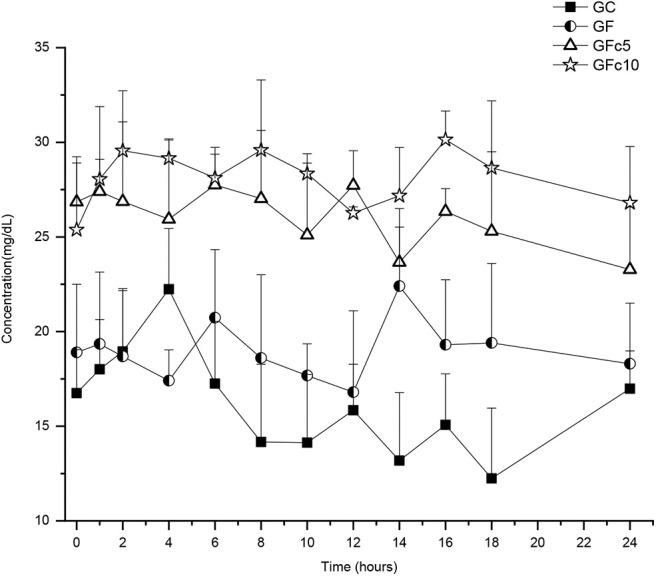
One day calcium serum profiles achieved with four calcium sources administered orally in 85-week-old Bovans-White hens: control group (GC), receiving a diet containing basal levels of 4.1% of calcium-carbonate; group GF treated as GC, but including the same dose of calcium-carbonate in FOLA pellets; group GFc5 treated as GF, but adding 6 ppm of capsicum-oleoresin (500,000 Scoville Heat Units [SHU]), and group GFc10 treated as GFc5 but with 1,000,000 SHU capsicum-oleoresin.